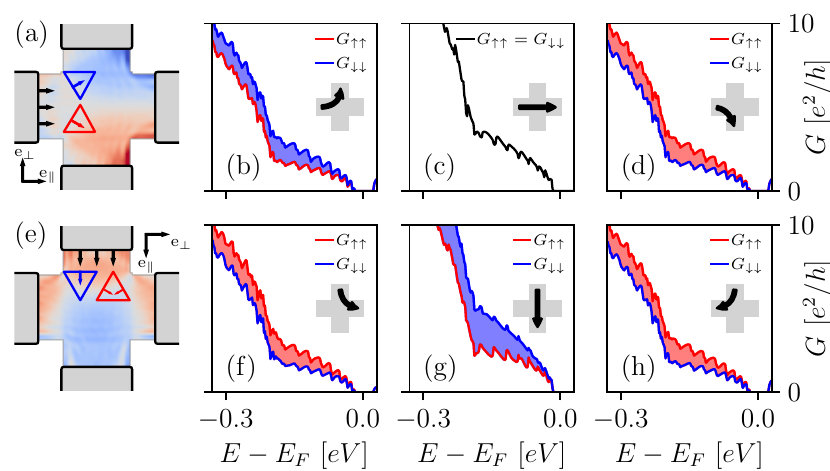
Figure 5: Spin polarization and spin density maps for the same 4-terminal device where the source lead is parallel to the zigzag (a) or the armchair (b) direction. Current is injected from the leads indicated by the black arrows. Individual panels (b-d) and (f-h) show the spin-resolved transmission of current leaving each respective device lead. Current is injected along the e ∥ direction, and the transverse direction is denoted by e ⊥ . The Fermi pockets are illustrated as colored triangles: red triangles indicate spin-up Fermi pocket, whereas blue triangles indicate spin-down. Fermi velocity the injected leads are shown as arrows perpendicular to the Fermi